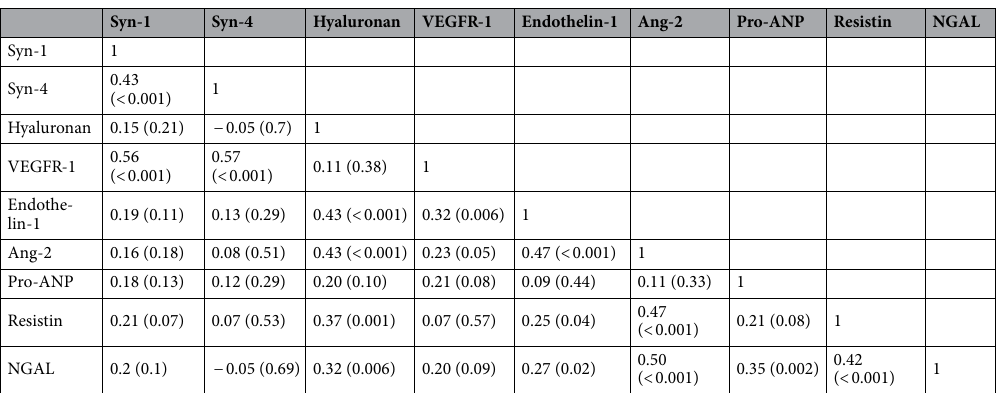
(data not shown). There was no correlation between Pro-ANP and any of the EG biomarkers.